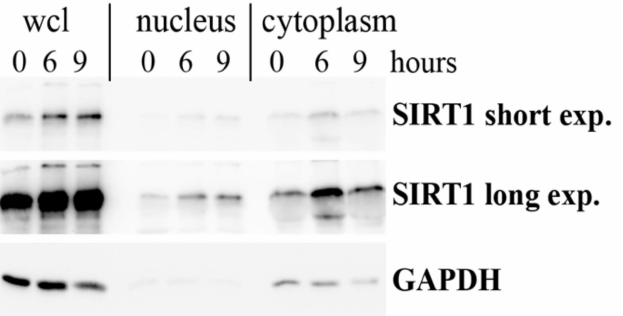
Figure A1. SIRT1 distribution in nucleus and cytoplasm. Immunoblots of whole-cell lysates (wcl), lysates from isolated nuclei (10 µ g) and cytoplasm (20 µ g) from RASFs, showing increased SIRT1 levels in both nuclear and cytoplasmic fractions after straining for 0–9 h.